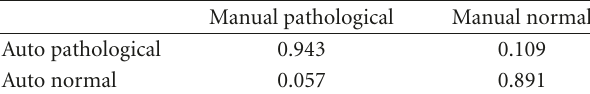
Table 4: Mean confusion matrix for the 10 training sets (One correlation